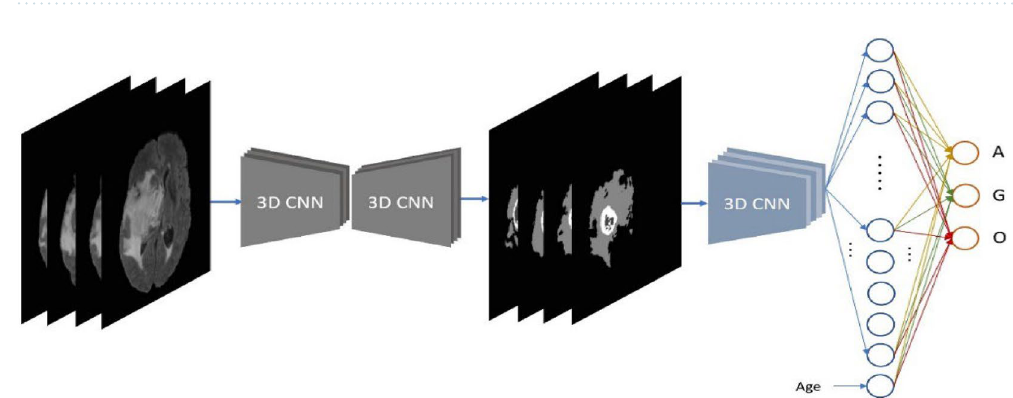
Figure 6. Pipeline of the proposed